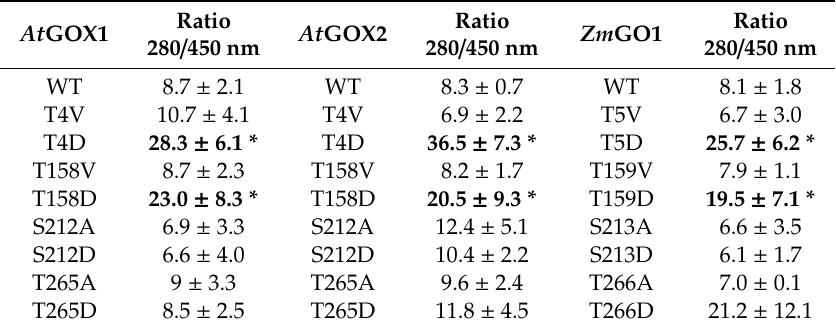
Table 4. A 280 / 450nm ratios of recombinant At GOX1, At GOX2 and Zm GO1 Table 4. A 280/450nm ratios of recombinant At GOX1, At GOX2 and Zm GO1 proteins.